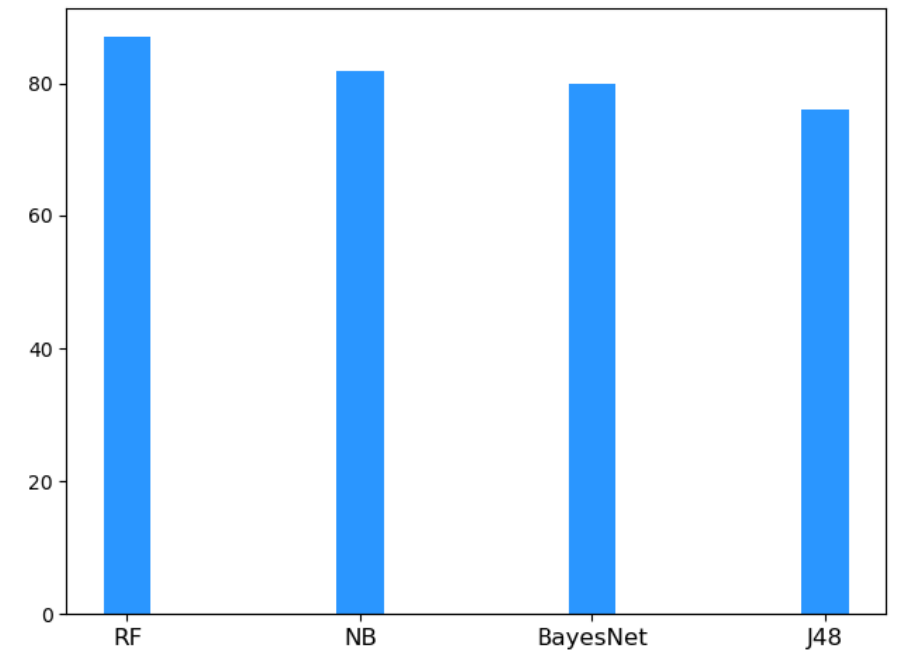
Figure 11. Comparison of classical machine learning approaches. Y -axis shows the F-measure.